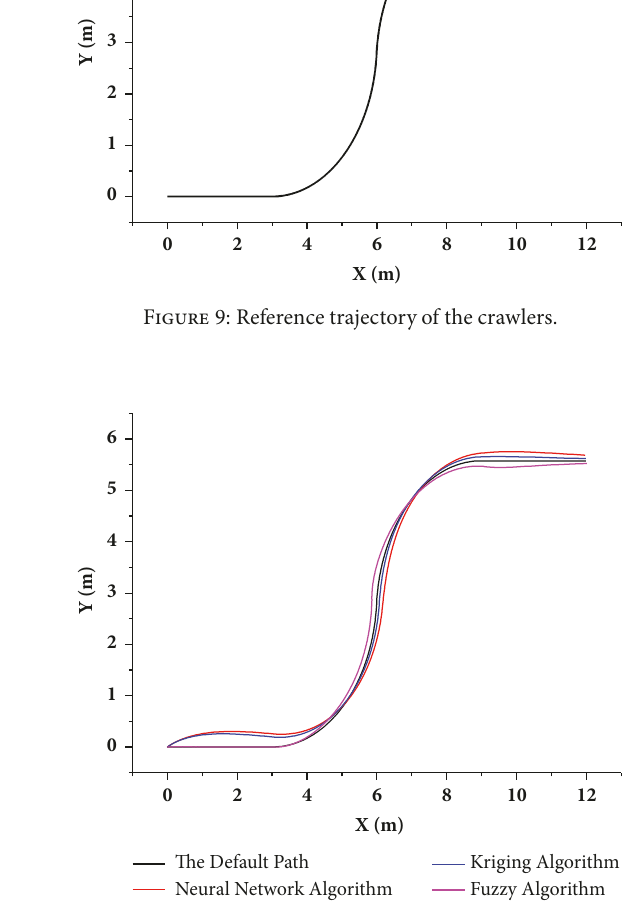
Figure 10: Result analysis of travel